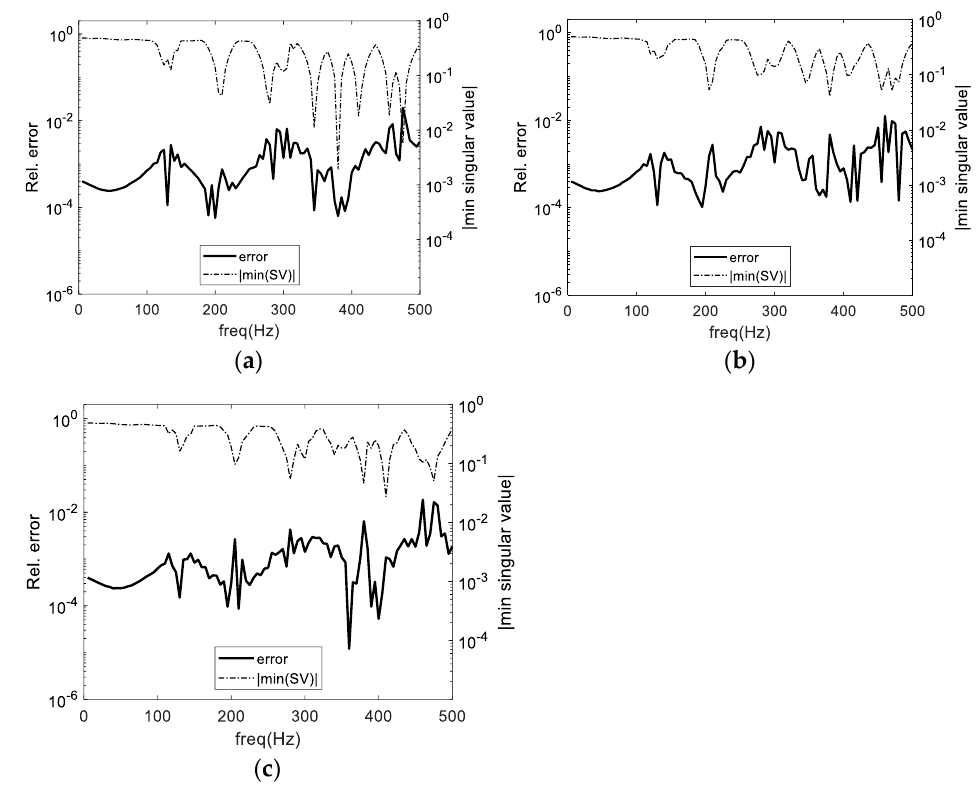
Figure 6. BEM relative error with one ( a ), two ( b ) and three ( c ) CHIEF points. The smallest singular value for each case is also plotted.